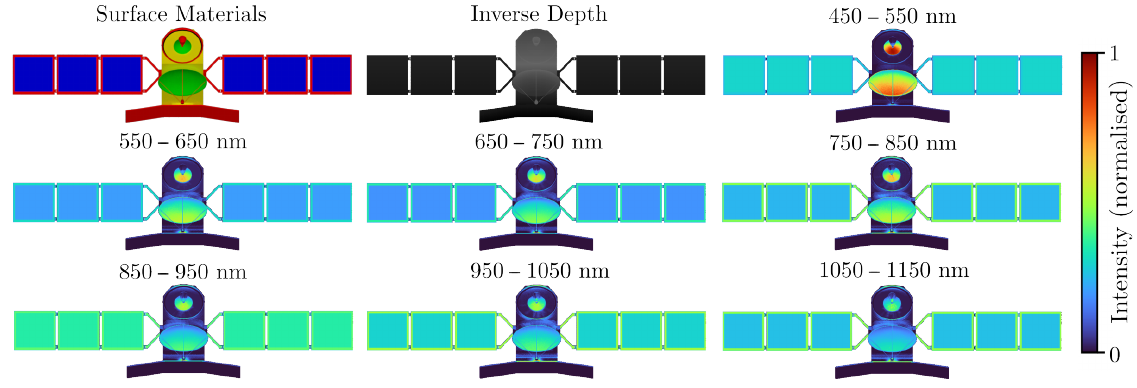
Figure 4. Renders of a box-wing satellite model. The top left image indicates the surface materials: red → aluminium, blue → solar cell, yellow → Multi-Layer Insulation (MLI), green → uniform reflectance. The other images provide a greyscale depth map and intensity images across different spectral bands; see colour